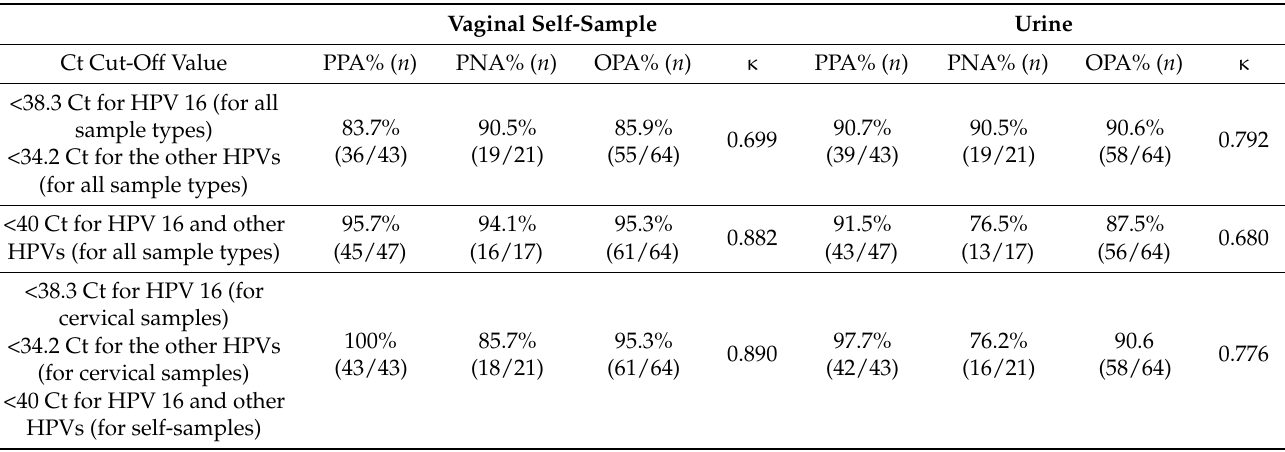
Table 2. Agreement in HPV detection of cervical and self-collected samples using different cut-off values.